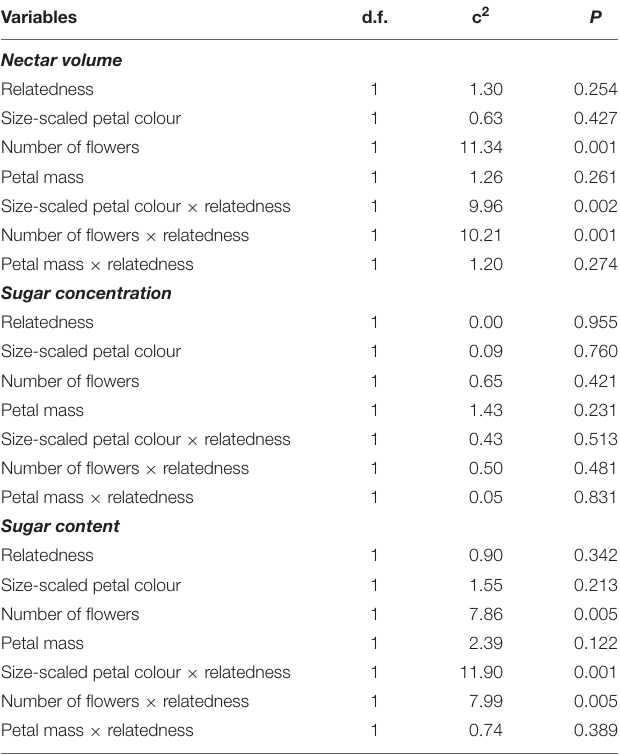
TABLE 2 | Effects of relatedness of the neighbouring plants on the relationship between flower signalling and reward.